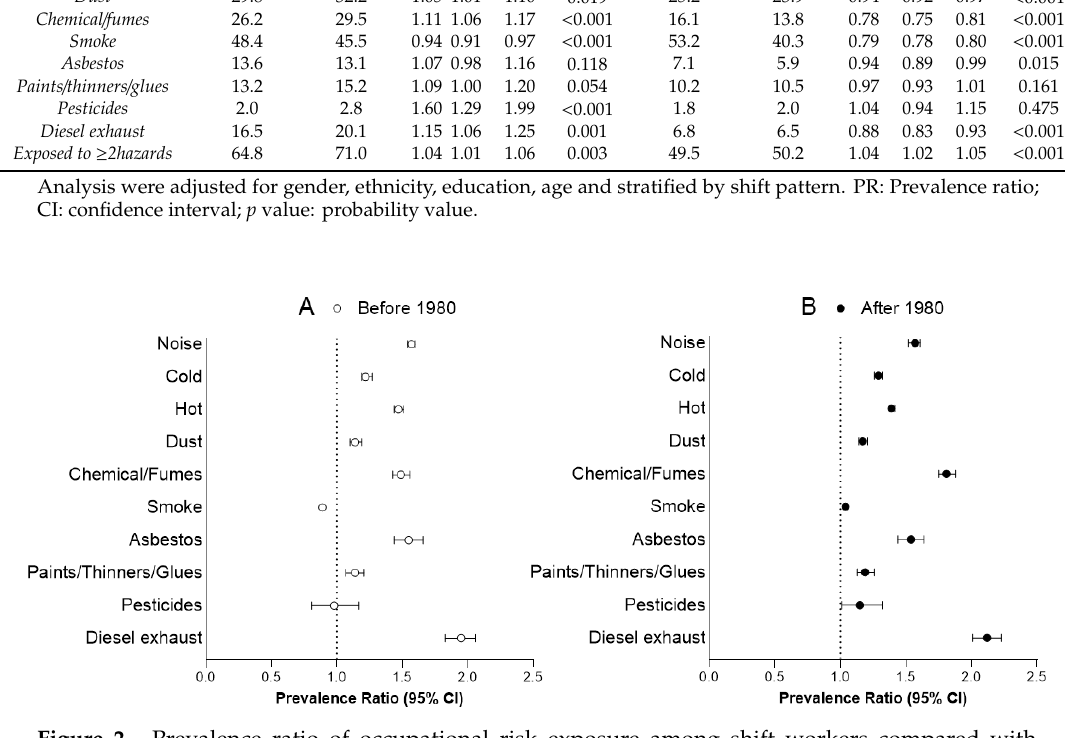
Figure 2. Prevalence ratio of occupational risk exposure among shift workers compared with other workers. ( A ) Prevalence for shift workers compared to other workers (reference) before 1980; ( B ) Prevalence for shift workers compared to other workers (reference) after 1980. Analysis controlled for sex, ethnicity, education level, age, and occupational category.